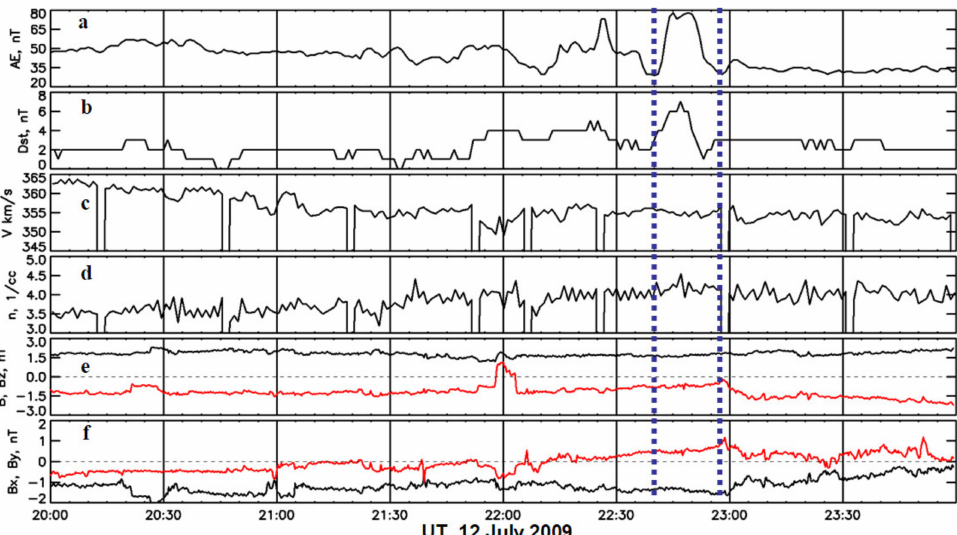
Figure 1. Upstream solar wind and geomagnetic conditions from 20 UT to 24 UT on 12 July 2009: ( a ) auroral electrojet (AE) index; ( b ) geomagnetic Dst index; ( c ) solar wind velocity; ( d ) solar wind density; ( e ) interplanetary magnetic field (IMF) strength (black curve) and Bz component (red curve) in GSM; ( f ) IMF components Bx (black curve) and By (red curve) in GSM. The interval of geomagnetic perturbations is indicated by the vertical blue dotted